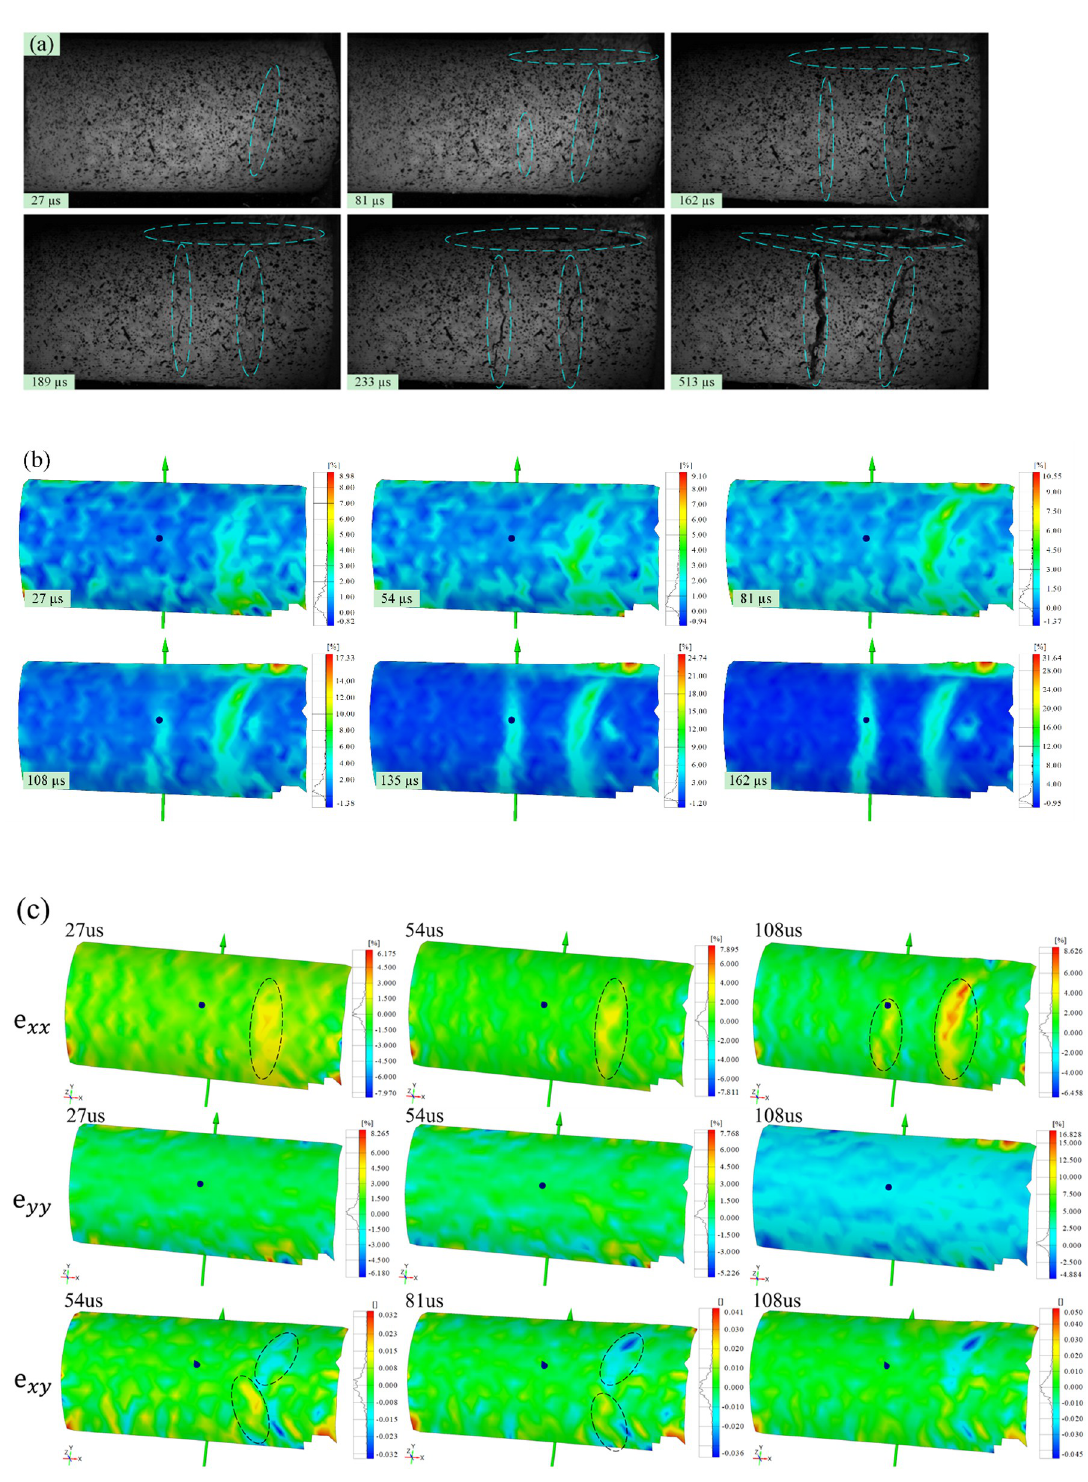
Fig 6. Images of the evolution of visible cracks and strain fields in different directions at a velocity of 30.0 m/s (the right face is the impacting face). (a) the high-speed images; (b) the maximum principal strain; (c) the axial (e xx ), vertical (e yy ) and shear (e xy ) strain.